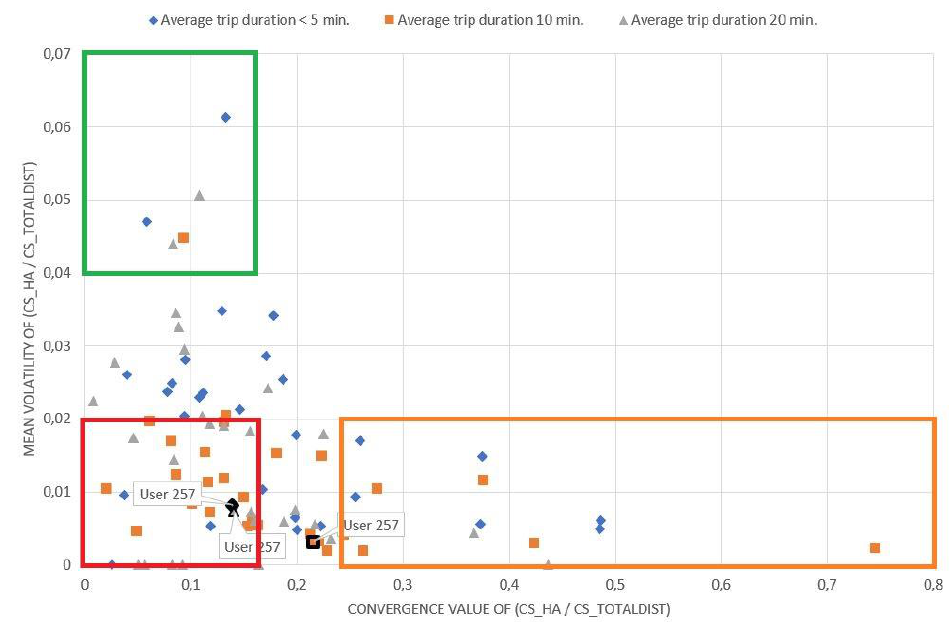
Figure 5. Aggressiveness versus volatility of driving behavior—harsh acceleration events.